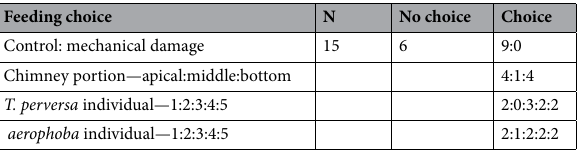
Table 1. Feeding choice experiments in Tylodina perversa . The total number of replicates is expressed by “N”. “No choice” denotes those experiments where T. perversa did not show a preference within 15 min after the sponges were presented. “Choice” shows the preference and number of times that option was